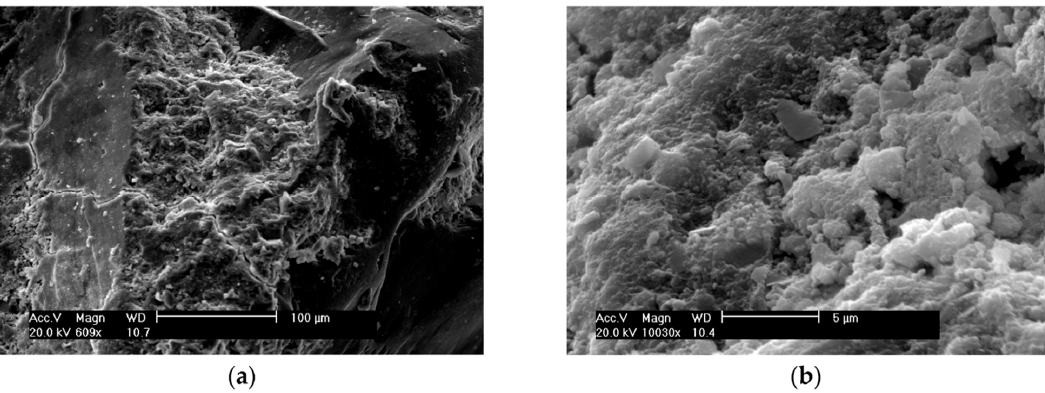
Figure 9. SEM images of concrete containing SF [83]. ( a ) Global Image—100 µ m ( b ) Detailed image 5 µ